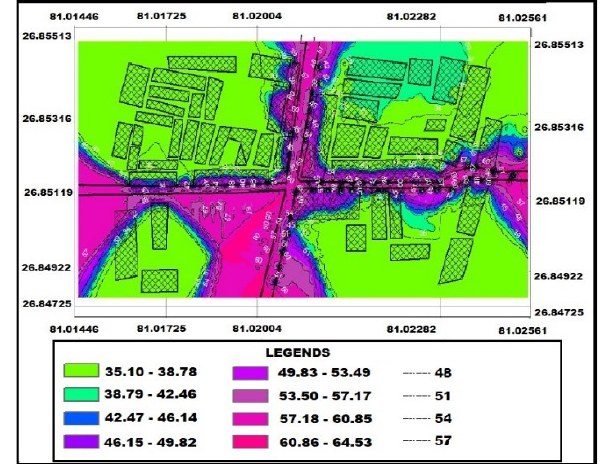
Figure 7. Noise level map of Haniman crossing for organized road for afternoon time.